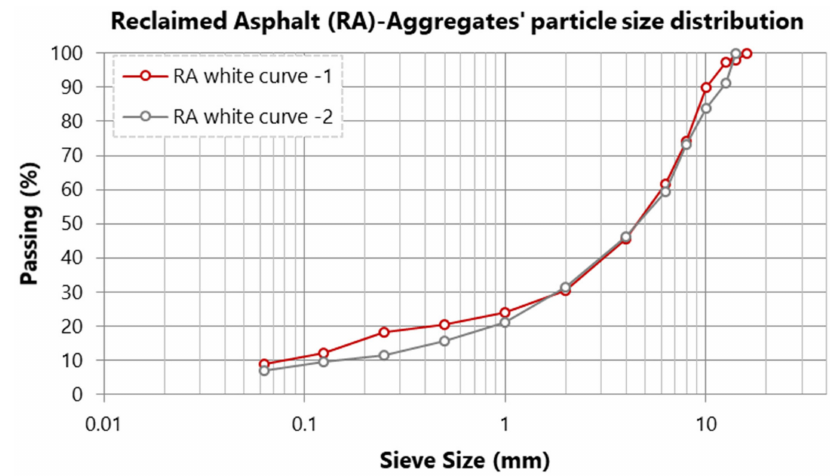
Figure 5. The grading curves of the RA samples after asphalt binder extraction (white curve) during the mix design and execution of the project.